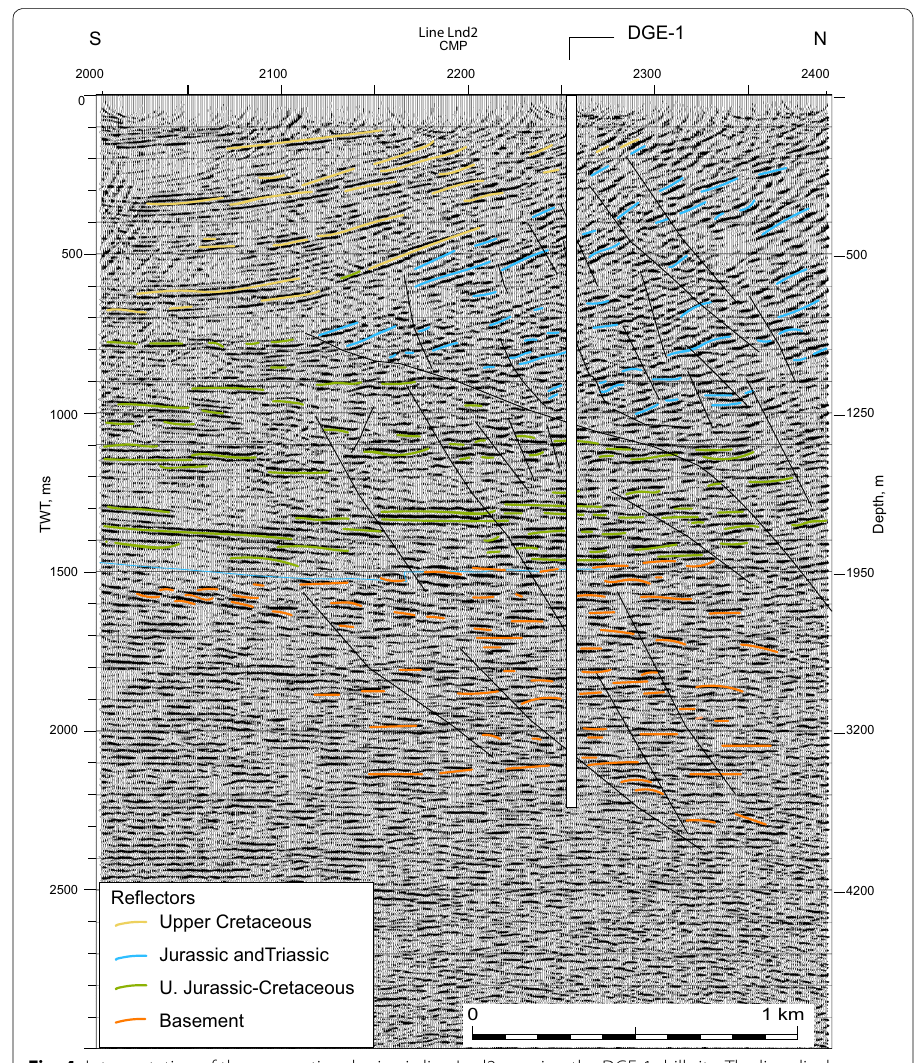
Fig. 4 Interpretation of the conventional seismic line Lnd2 crossing the DGE‑1 drill site. The line displays a ca. 2000‑m‑thick sedimentary succession including a complex thrusted rock block overlying the crystalline basement. Scattered reflectors in the basement are interpreted to represent bodies and dykes of metabasite and dolerite. The depth conversion is based on velocity data from the VSP survey and the Full‑Wave